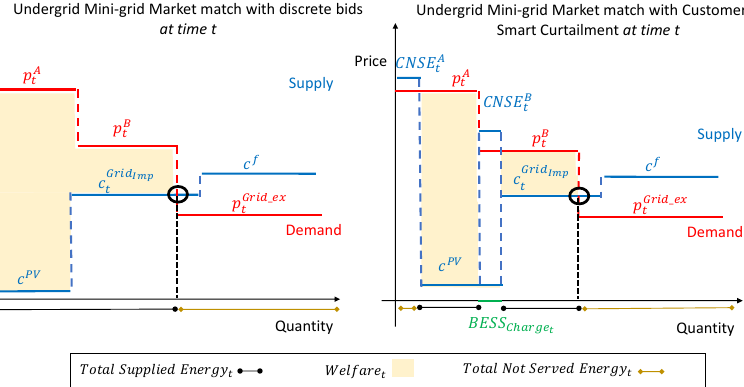
( left ) and with t